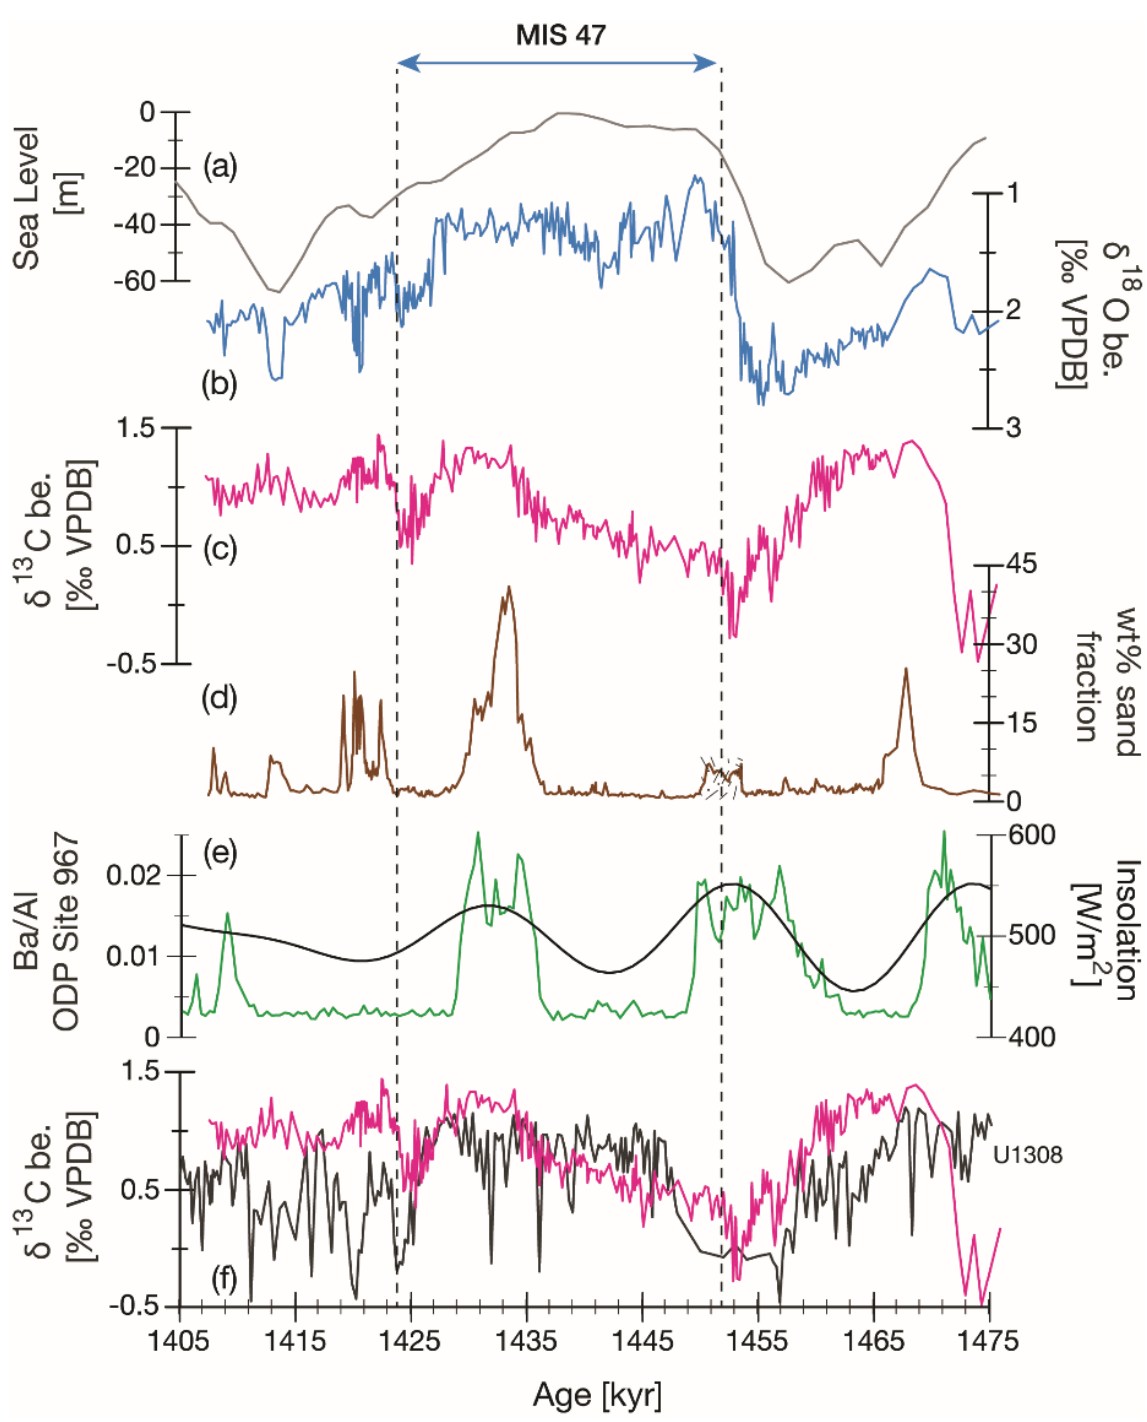
Figure 3. Focus on Mediterranean Outflow Water history at IODP Site U1387: ( a ) Sea level relative